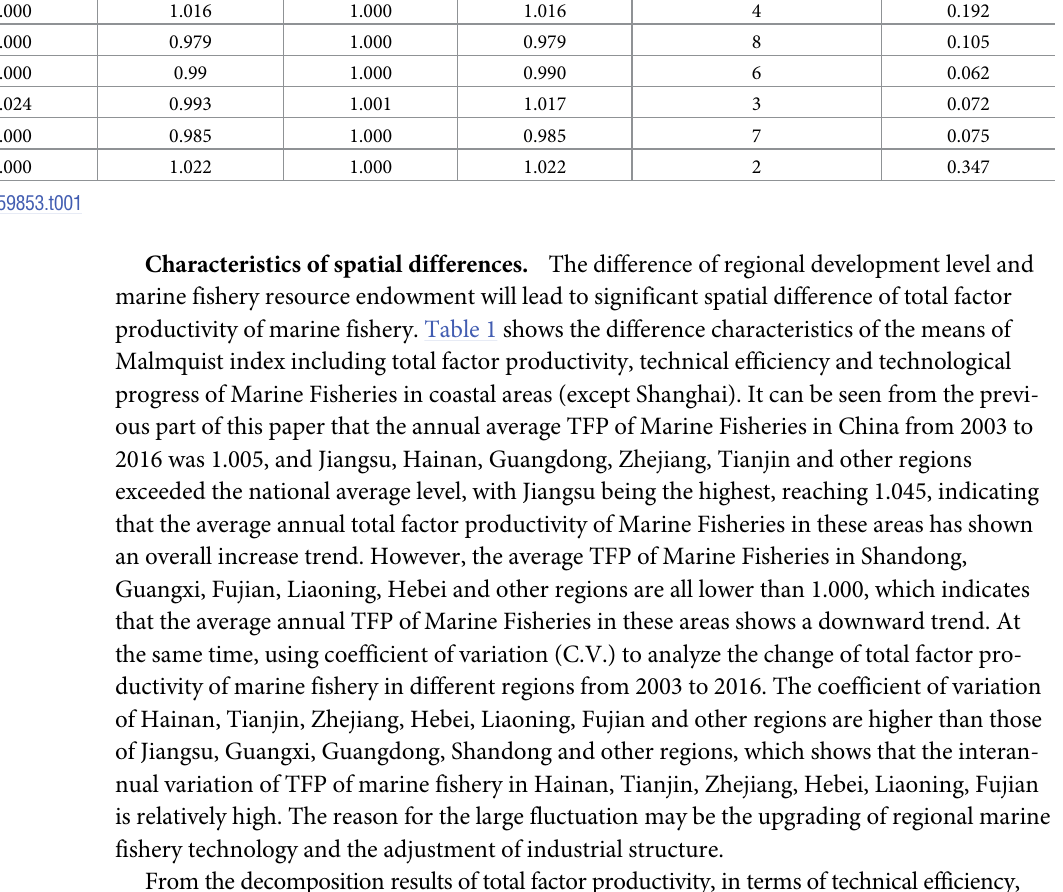
Table 1. Summary of the means of Malmquist index of marine fisheries in various coastal regions. regions